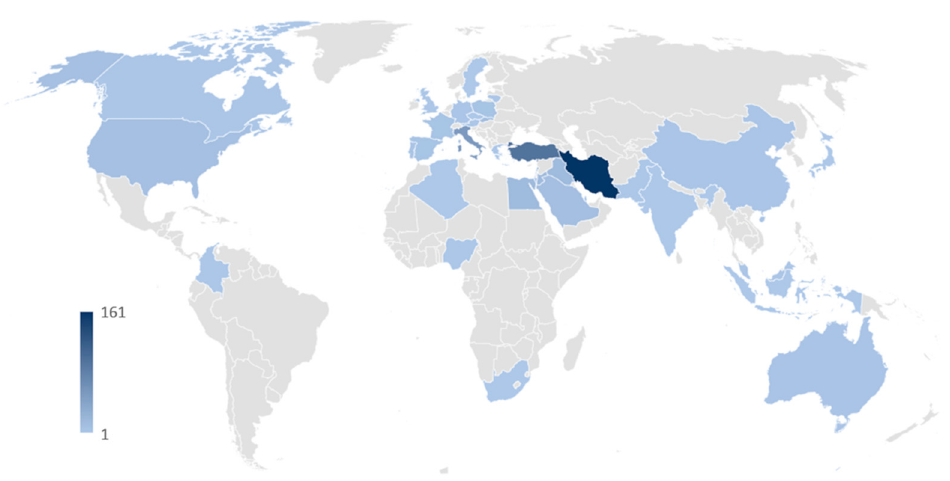
Figure 4. Geographical contribution to the scientific sector in terms of nationality of the authors. The color bar on the left corner illustrates the relation between the intensity of the blue color and the